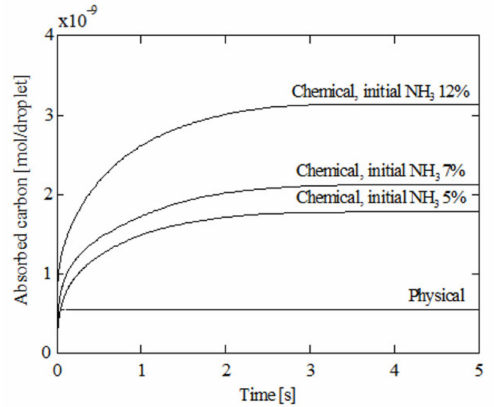
Figure 11. Absorbed carbon under physical and chemical absorption; 5% initial ammonia concentra- tion, 100 ◦ C initial gas temperature, 5 ◦ C initial liquid temperature, and 1000 µ m initial